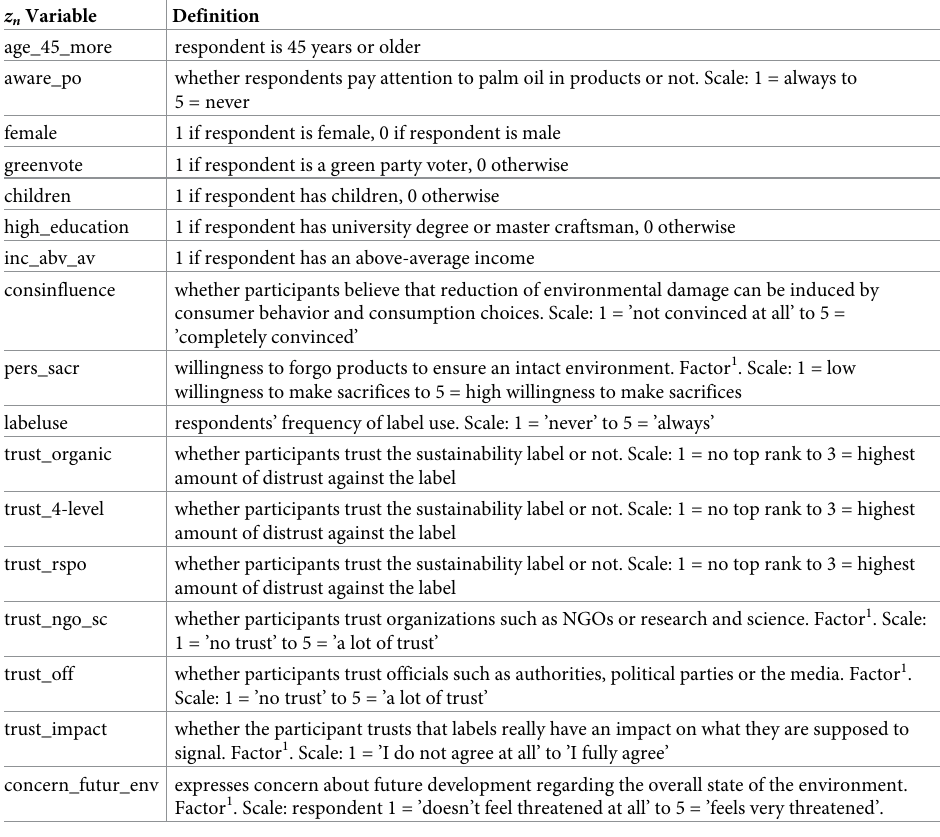
Table 4. z n Variable